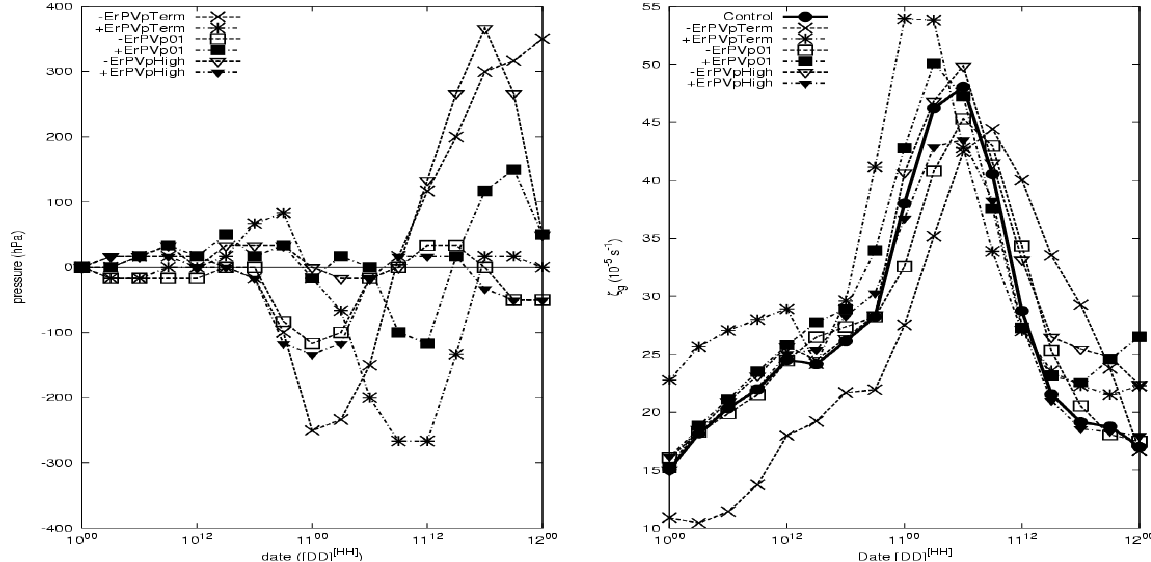
Fig. 14. Labels as in Fig. 11, but left panel: evolution of the depth of the cyclone rescaled to control simulation results (defined as the first minimal vorticity value above the centre of the cyclone, left). Right panel: evolution of the vorticity of the cyclone at a distance of 200km (defined like in Campins et al., 2000). Each figure has been temporally filtered through a mobile-average filter of 3